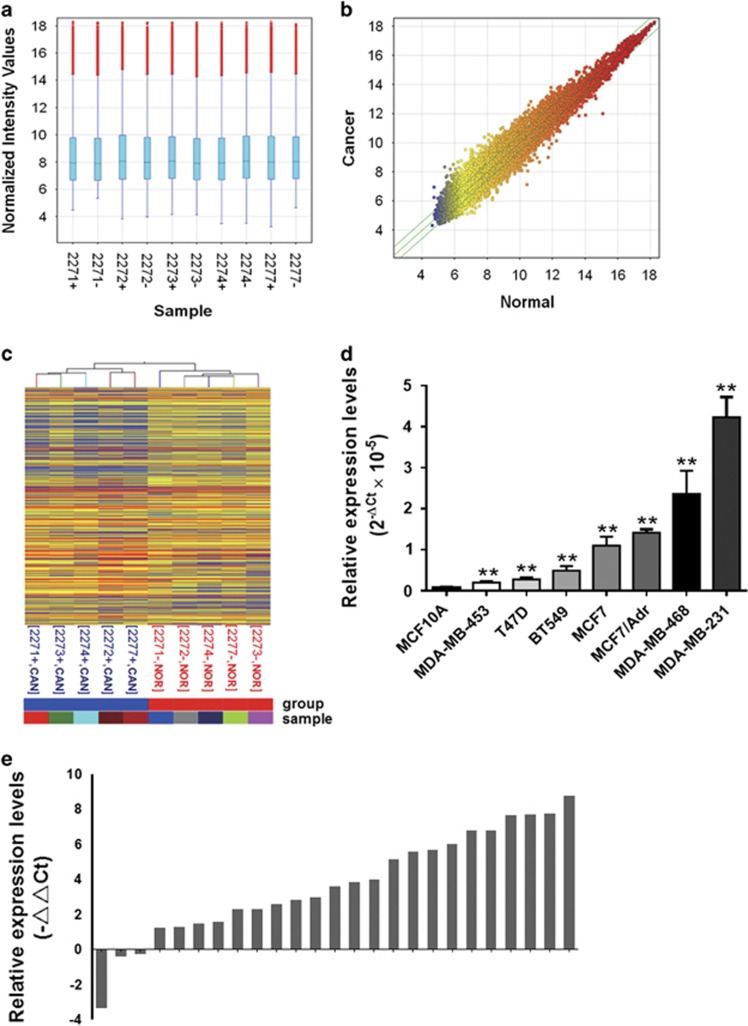
LncRNA microarray screening and qPCR validation for differentially expressed lncRNAs in breast cancer. The microarray results in five pairs of fresh breast cancer tissues and corresponding para-cancer normal tissues were shown in (a, b, and c). (a) Quality assessment of lncRNA data after filtering using box plot. The box plot is a convenient way to quickly visualize the distributions of a data set. It is commonly used for comparing the distributions of the intensities from all samples. After normalization, the distributions of log2 ratios among all tested samples are nearly the same. Red bars indicate abnormal values. Blue boxes, the bottom and top of the box are the first and third quartiles, and the band inside the box is the median. (b) The scatter plot for assessing the lncRNA expression variation between cancer and para-cancer tissues. The values of X and Y axes in the scatter plot are the normalized signal values of the samples (log2 scaled) or the averaged normalized signal values of groups of samples (log2 scaled). The green lines are fold change lines (the default fold change value given is 1.5). The lncRNAs above the top green line and below the bottom green line indicated >1.5-fold change of lncRNAs between the two compared samples or the two compared groups of samples. (c) Hierarchical clustering for ‘differentially expressed lncRNAs for cancer versus para-cancer'. ‘Red' indicates high relative expression, and ‘blue' indicates low relative expression. The result from hierarchical clustering shows a distinguishable lncRNA expression profiling among samples. (d) qPCR detection showed all breast cancer cell lines bear higher expression level of APOC1P1-3 than non-tumoral mammary epithelial cell line MCF10A. Data are shown as the mean±S.D. Error bars indicate S.D. **P<0.01 versus control (MCF10A). (e) qPCR detection in 25 pairs of fresh tissues showed APOC1P1-3 was highly expressed in breast cancer tissues. ΔΔCt=ΔCt (cancer)−ΔCt (normal), ΔCt=Ct (APOC1P1-3)−Ct (GAPDH)